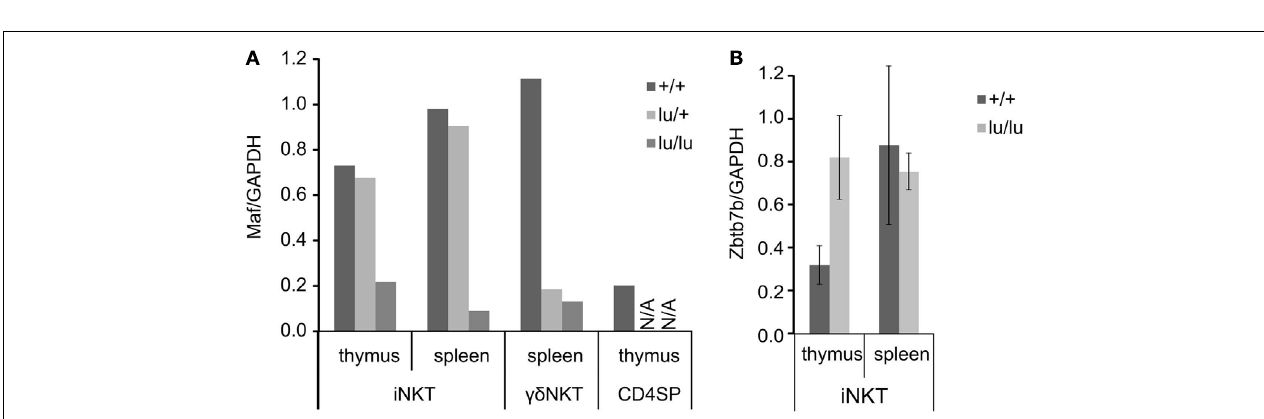
FIGUREA1 | Surface phenotype of iNKT cells from PLZF + / + , PLZFl u/ + and PLZF lu/lu mice. Cells from thymi (A) , spleens (B) , and livers (C) of mice with